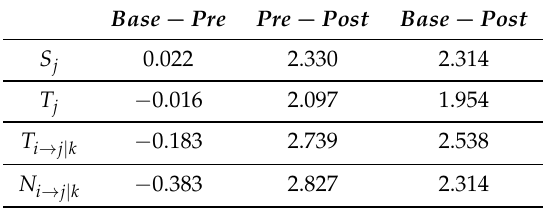
Figure 6. Information dynamics of scalp EEG signals measured during focal seizures. Plots and symbols are as in Figure 5. Table 2. Cohen’s d effect size-Generalized seizures-Scalp signals.